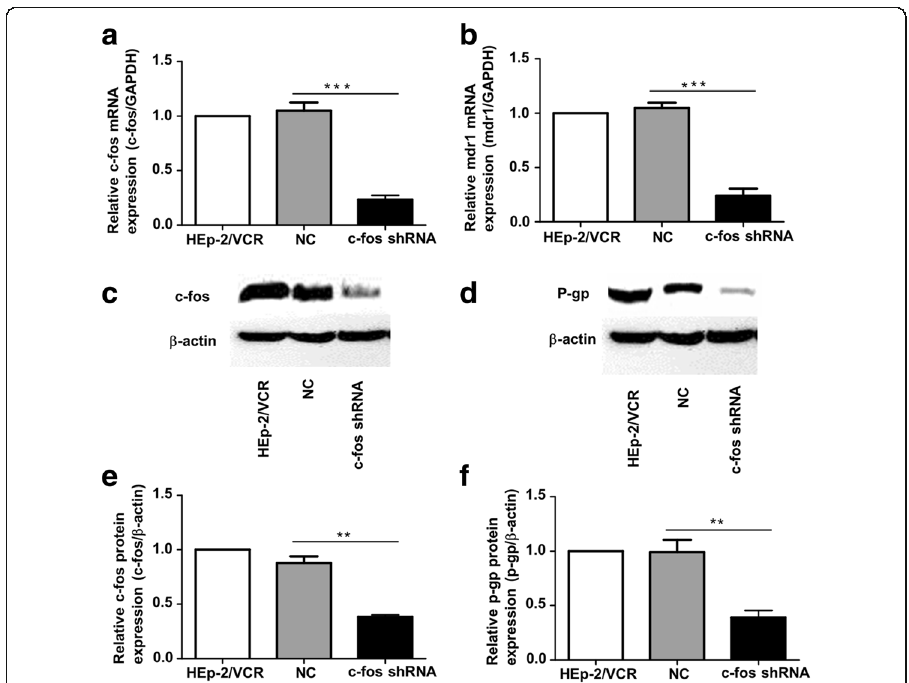
Fig. 3 Expression of mdr1 and p-gp in HEp-2/VCR cells after c-fos knockdown. a , b Real-time PCR analysis of the expression of c-fos and mdr1 in various groups of cells. The HEp-2/VCR cells with c-fos knockdown were named the c-fos shRNA group, the negative control (NC) was HEp-2/VCR cells transfected with an empty vector. c , d Western blot assessment of the expression of c-fos and P-gp in various groups of cells. e , f The statistical quantification analyses of c-fos and p-gp protein levels in c-fos knockdown HEp-2/VCR cells. Data are shown as the means ±SD. **p < 0.01, ***p <